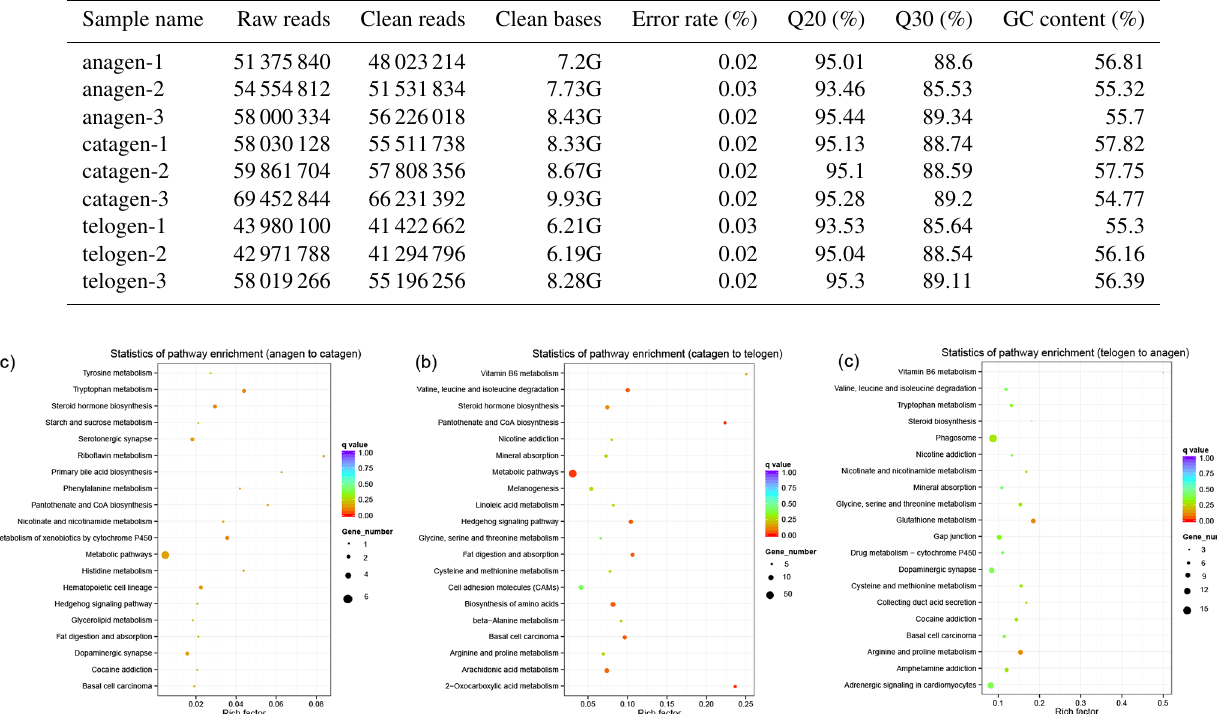
Figure 3. KEGG pathway analysis of DEGs. (a) DEGs between anagen and catagen. (b) DEGs between catagen and telogen. (c) DEGs between telogen and